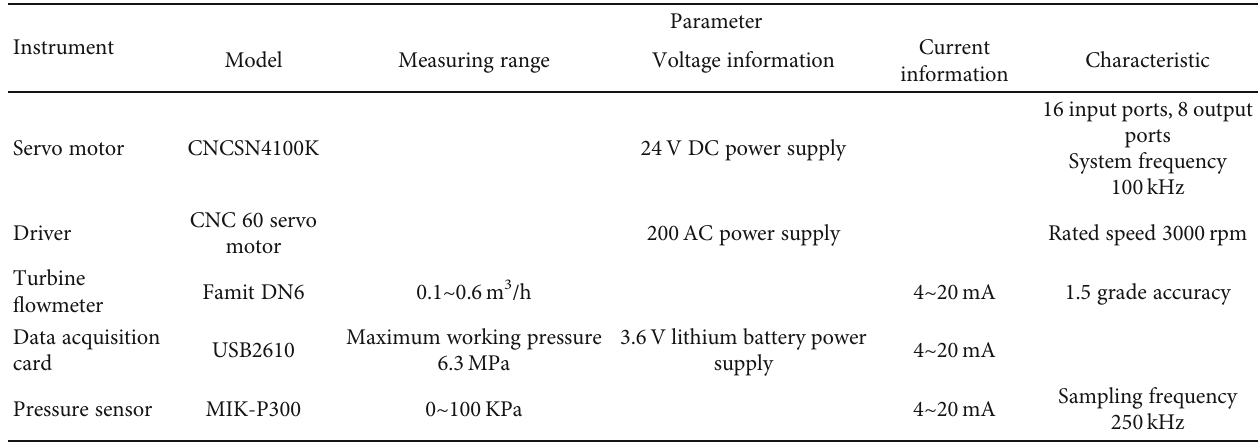
Table 3: Test equipment parameter.